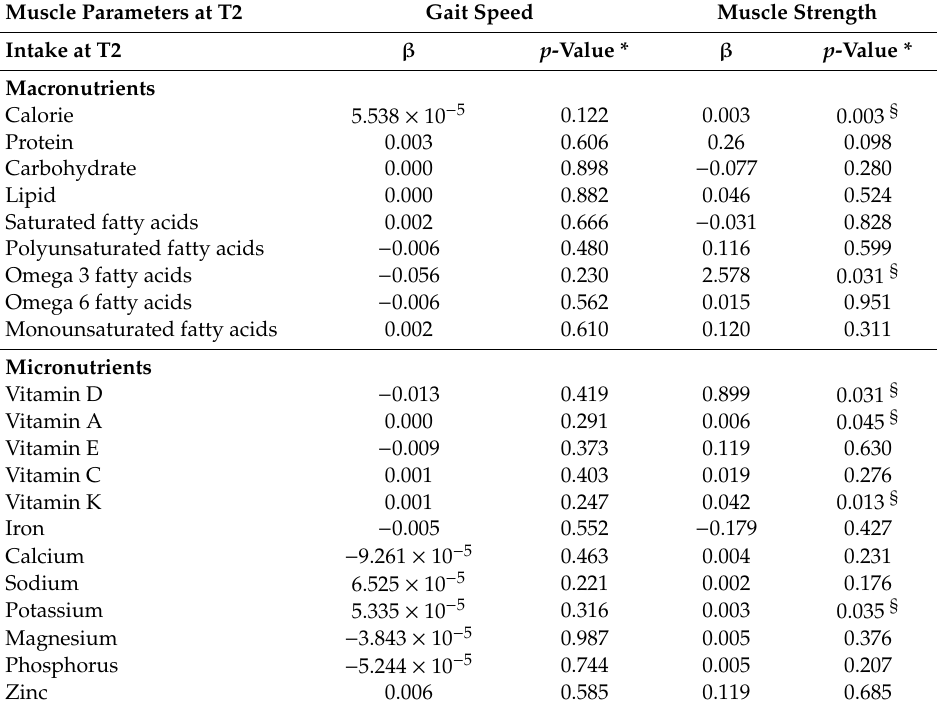
Table 3. Baseline associations between macro- and micronutrient consumption and muscle health components.